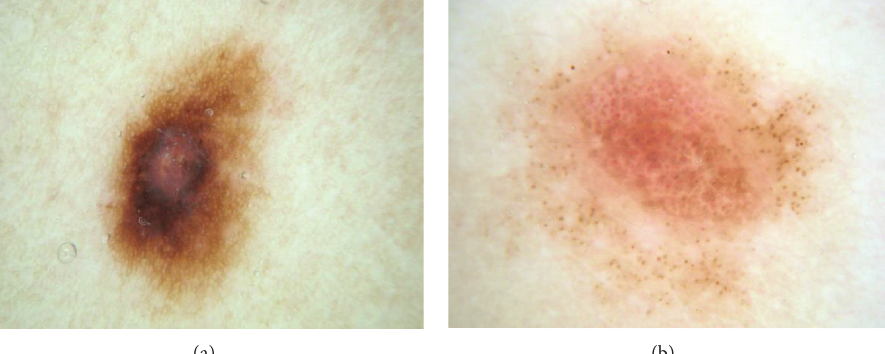
Figure 6: (a) Benign nevus. Central pink only. (b) Congenital nevus, no biopsy, central-only pink. In this nevus, pink extends nearly to the periphery but diminished at the far rim. Neither lesion was biopsied.